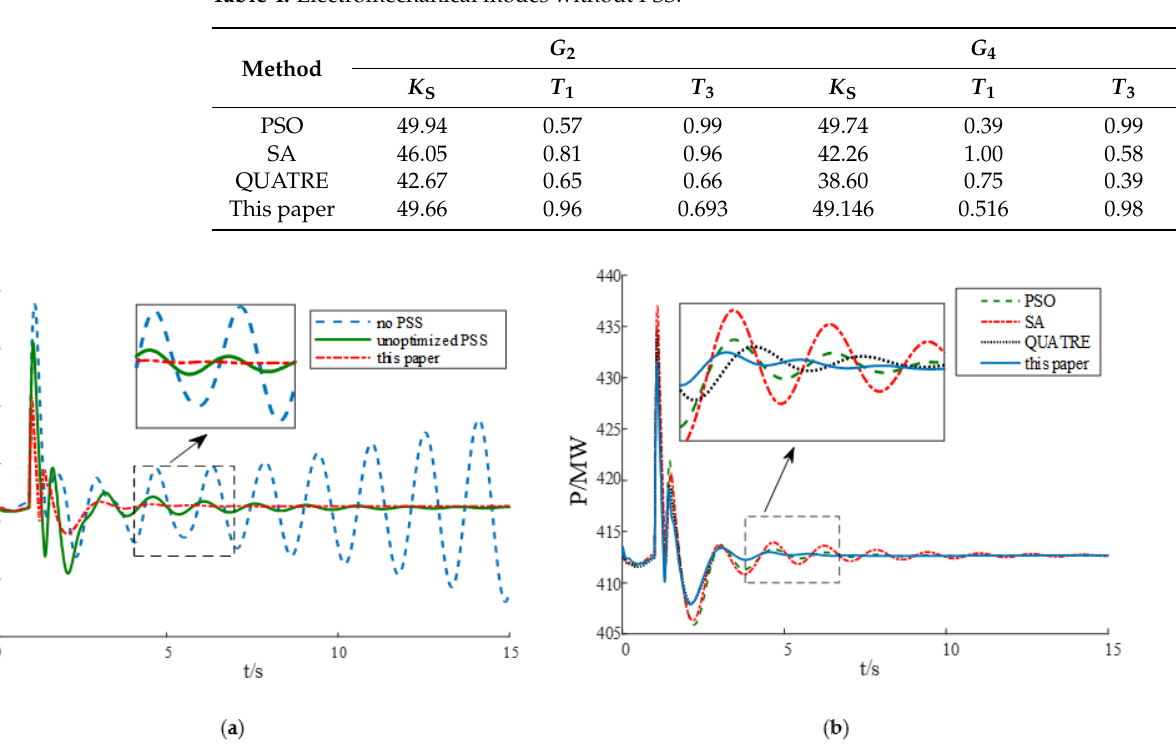
Figure 7. Active power output of tie-line: ( a ) Comparison between the method in this paper